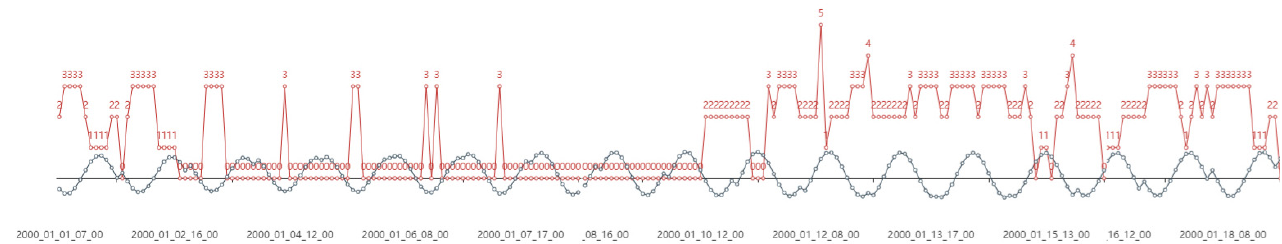
Figure 8. The hourly type and tidal height from 7 January 2000 to 18 January 2000. The red line indicates the bar type at each hour, while the blue line represents the height of tide.